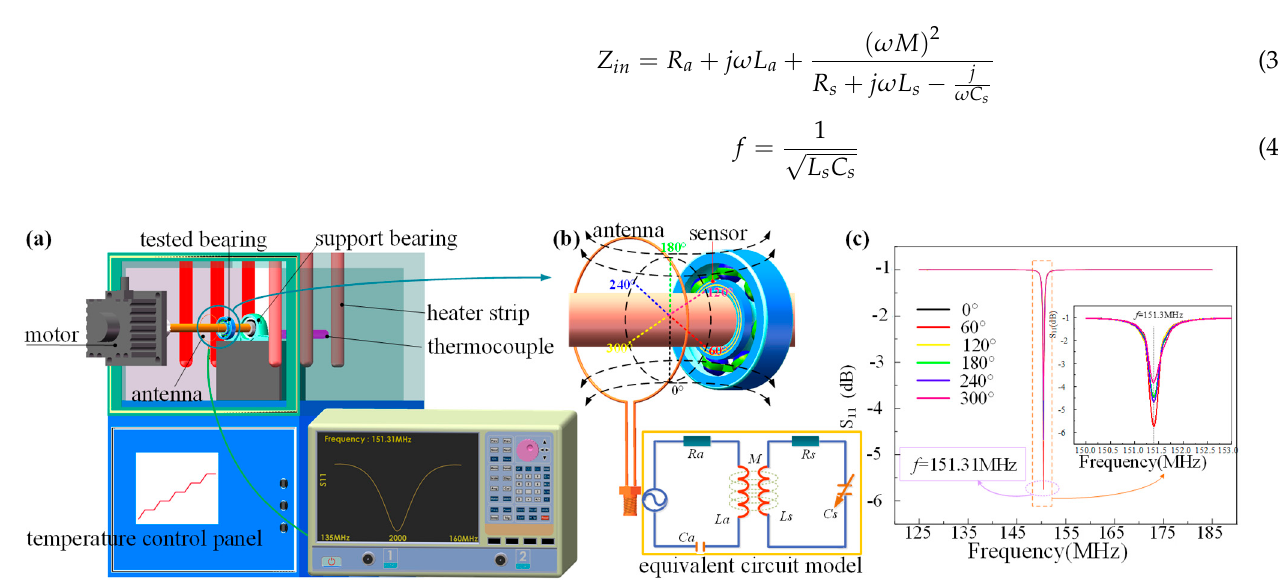
Figure 5. ( a ) Wireless LC temperature sensor and its application in a wireless measurement system of bearing temperature; ( b ) wireless transmission of temperature signal; ( c ) coupling between the antenna and coil at different angles simulated using ANSYS.